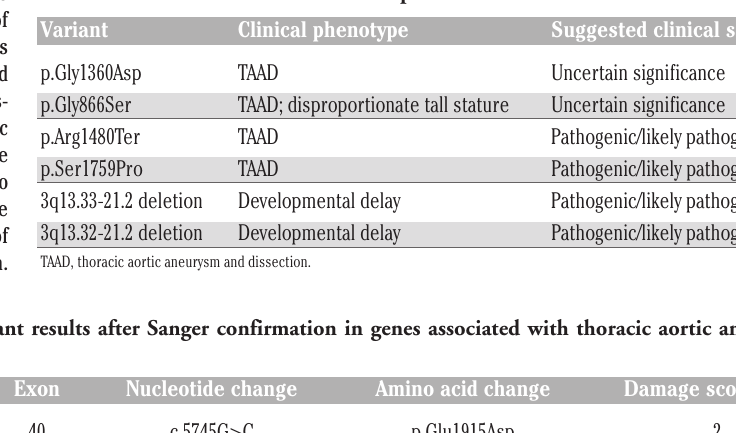
clinical TAAD panel was negative for any path- ogenic variants. The testing did reveal a